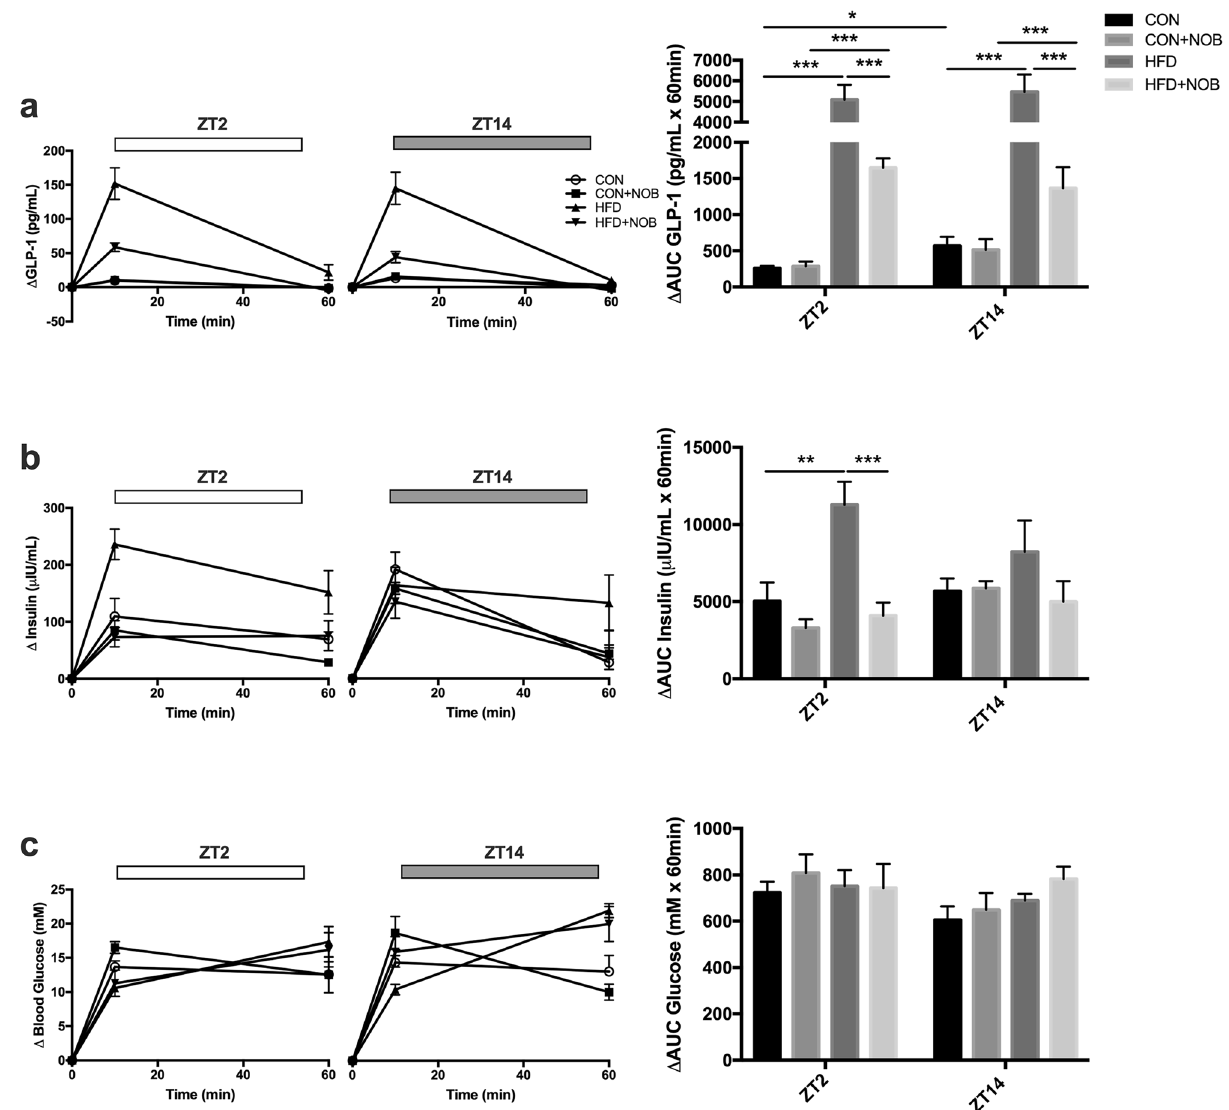
Figure 4. Nobiletin reduces GLP-1 secretion to more physiological levels following HFD-induced disruption. Individual responses at ZT2 and ZT14 as well as the corresponding delta area-under-the-cure (ΔAUC) for ( a ) GLP-1, ( b ) insulin, and ( c ) glucose following an OGTT in control (CON)- and high-fat diet (HFD)-fed mice with and without nobiletin (NOB) supplementation. n = 6; *p < 0.05 **p < 0.01 ***p <